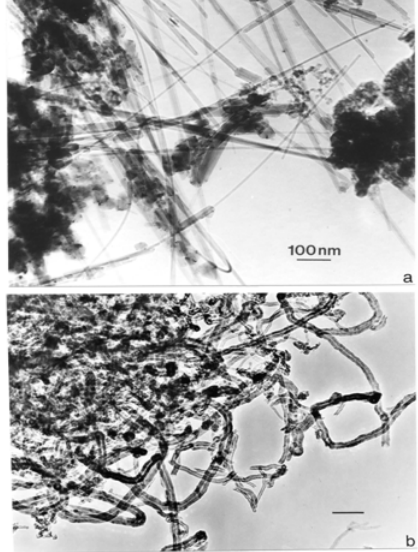
Figure 2: Arc evaporation produced MWCNTs (a) and metal catalyst produced MWCNTs (b). (b) is after Soto, et al. [29]. The magnification in (b) is shown in (a).